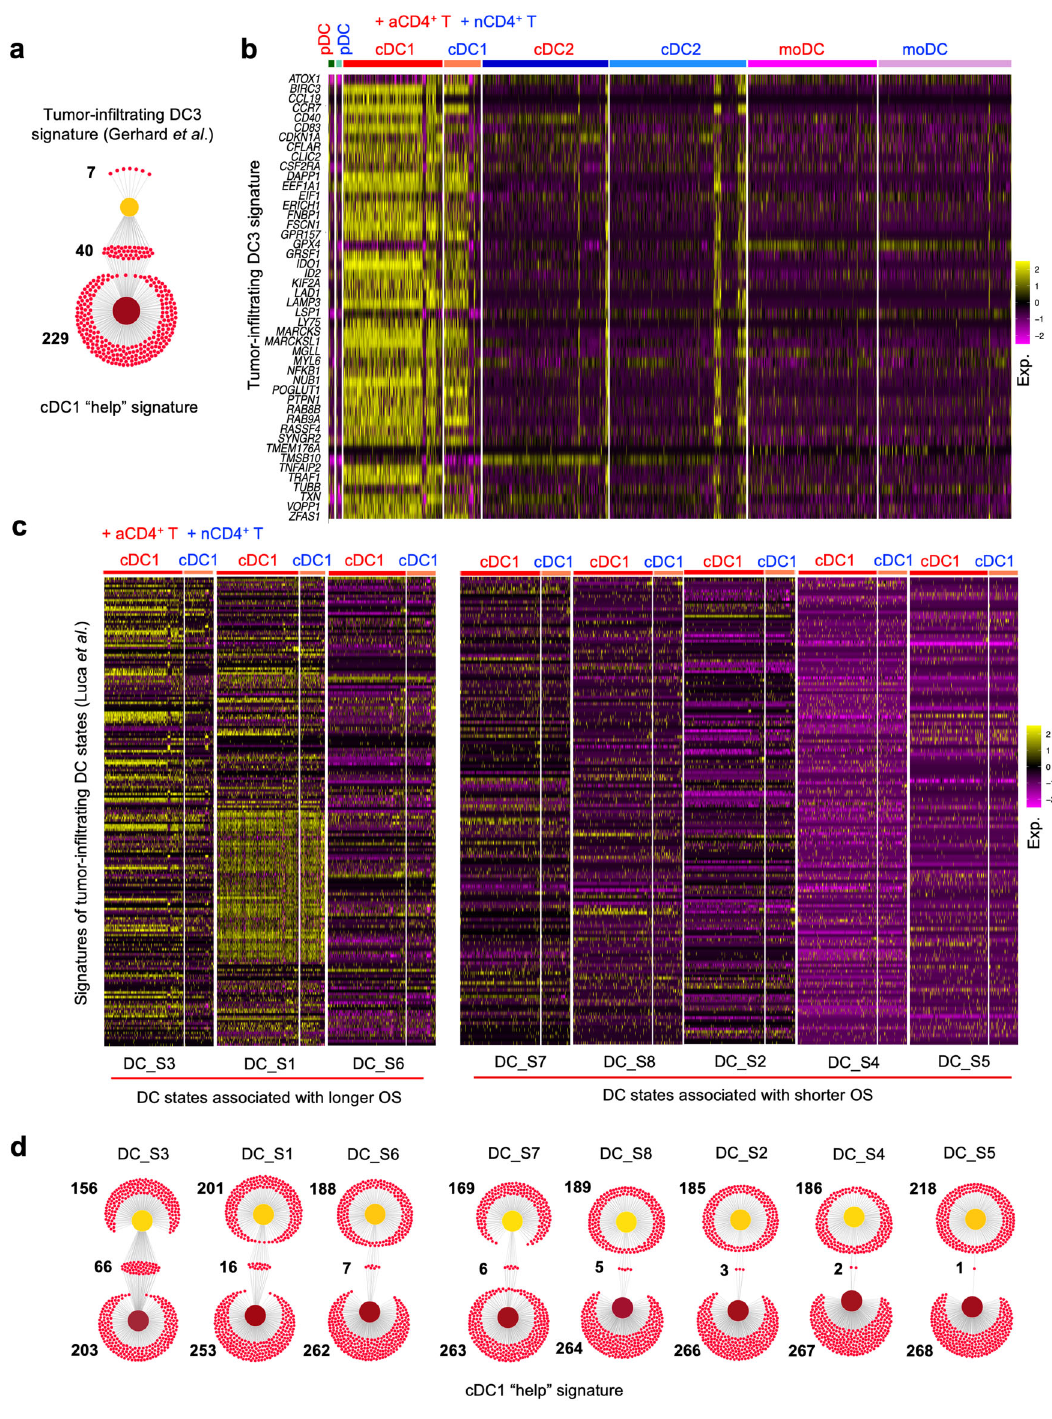
b Heatmapsdepictingtheexpressionoftumor-in fi ltratingDC3signaturegenes 17 in each DC subset under “ help ” (aCD4 + T) or “ no help ” (nCD4 + T) conditions. c Heatmap depicting the expression of signature genes from the indicated tumor- in fi ltrating DCstates (DC_S3 etc.) that are associated with longer or shorter overall survival (OS) 18 in cDC1 under “ help ” (aCD4 + T) or “ no help ” (nCD4 + T) conditions. d VenndiagramsdepictingnumbersofoverlappinggenesbetweenthecDC1 “ help ” signature and the tumor-in fi ltrating DC signatures of 8 different states de fi ned in the study of Luca et al. 18 .